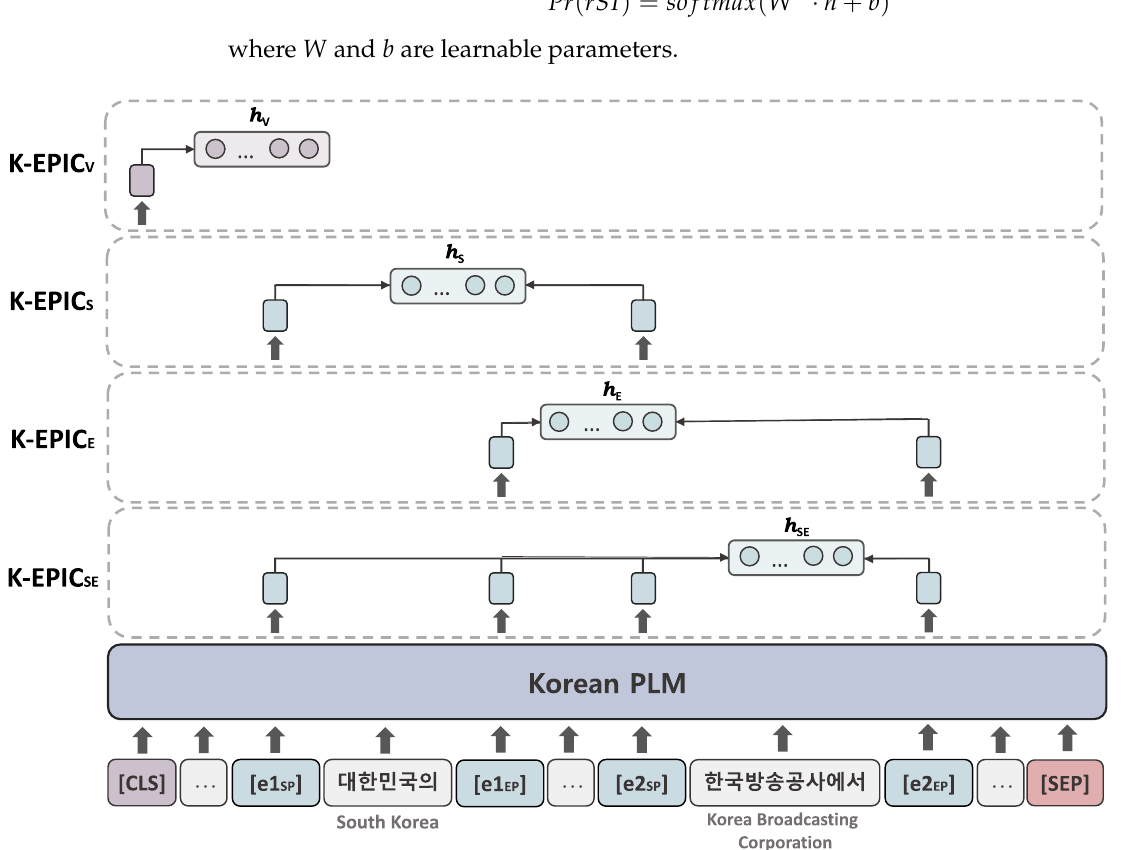
Figure 3. Four different types of final representations. In the example sentence, “Korea Broadcasting Corporation” is the subject entity and “South Korea” is the object entity. K-EPIC V only utilizes the [CLS] token, whereas K-EPIC S and K-EPIC E utilize the start position token and end position token, respectively. K-EPIC SE exploits all entity position tokens, which are the start position tokens and end position tokens of both entities.